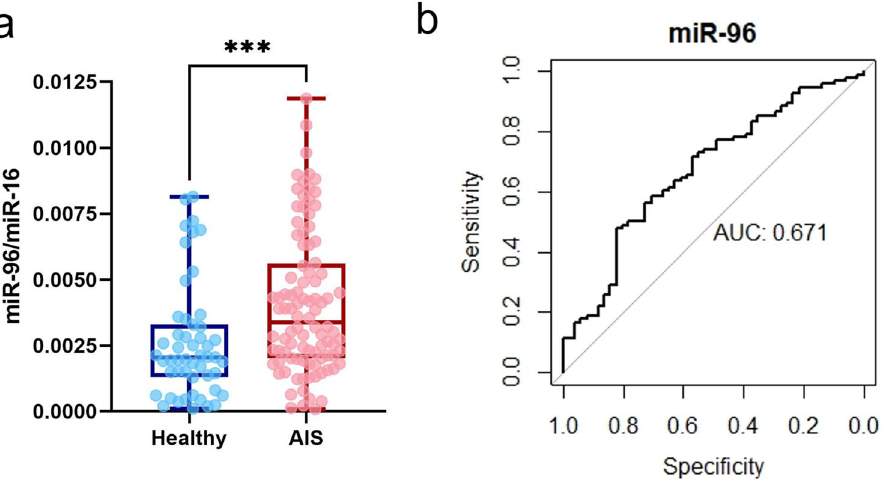
Figure 3. Plasma miR-96-5p levels in AIS and healthy girls. ( a ) Difference of plasma levels of miR-96-5p between AIS and healthy girls. Expression levels of miR-96-5p was normalized by plasma miR-16 levels. ***p ≤ 0.001. ( b ) Receiver operating characteristic (ROC) curve and AUC of plasma miR-96-5p